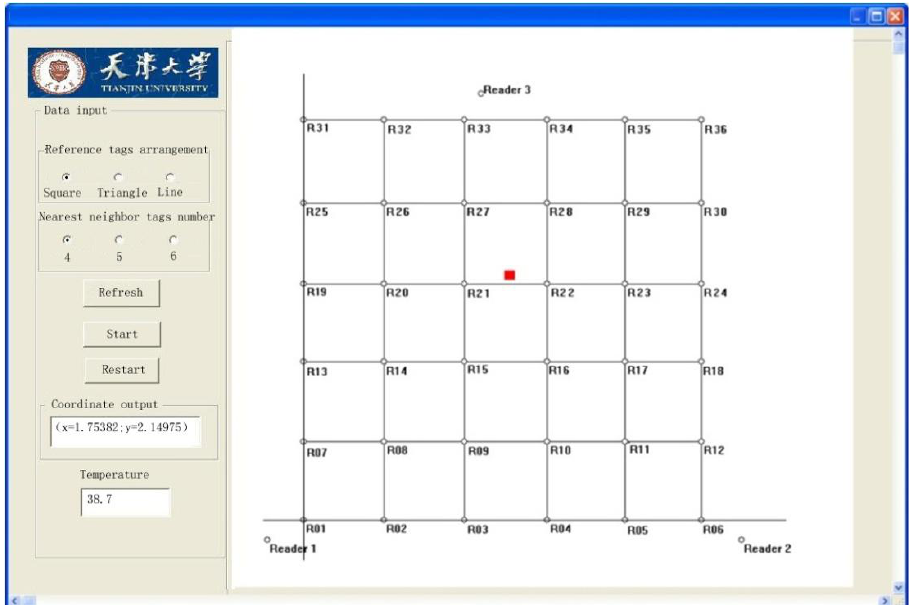
Figure 10. Localization system